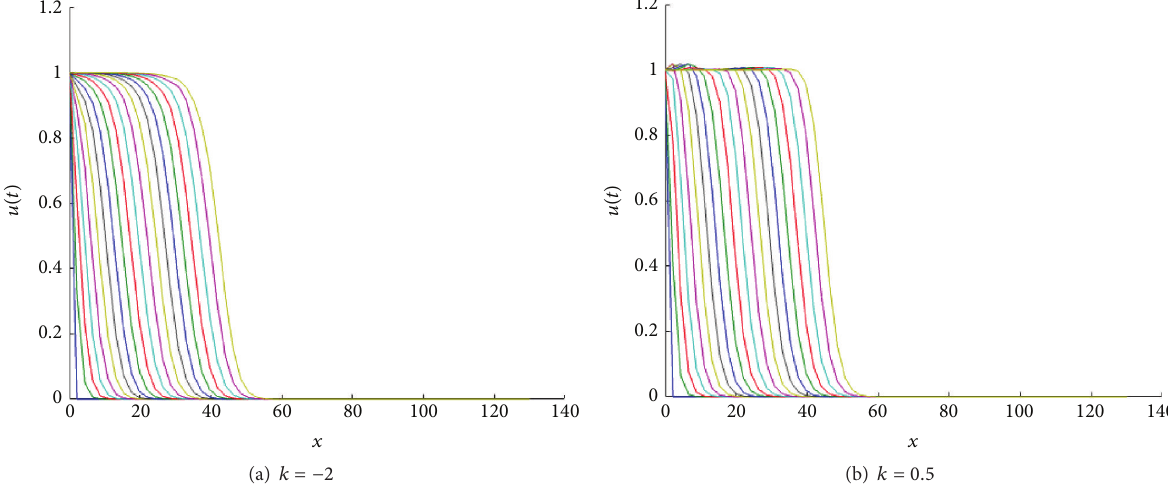
Figure 18: Front traveling waves solutions of (39) for ℎ 󸀠 (𝑢) = 𝑢 + 𝑘𝑢 2 at equal time intervals 𝑡 = 1, 2,3, . .. with 𝑔(𝑢) = 𝑢(1 − 𝑢) and 𝐷(𝑢) = 𝑢(1.0 + 𝛽𝑢) for 𝛽 = 1 . The values for 𝑘 are indicated in each